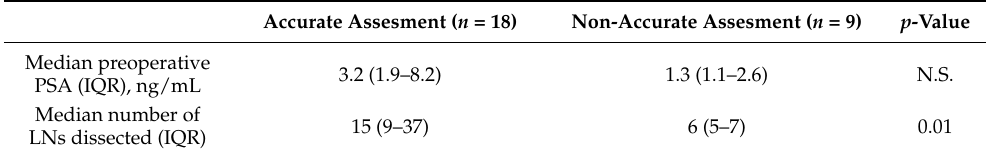
Table 3. The differences between preoperative PSA levels and the numbers of dissected lymph nodes between accurately and non-accurately assessed